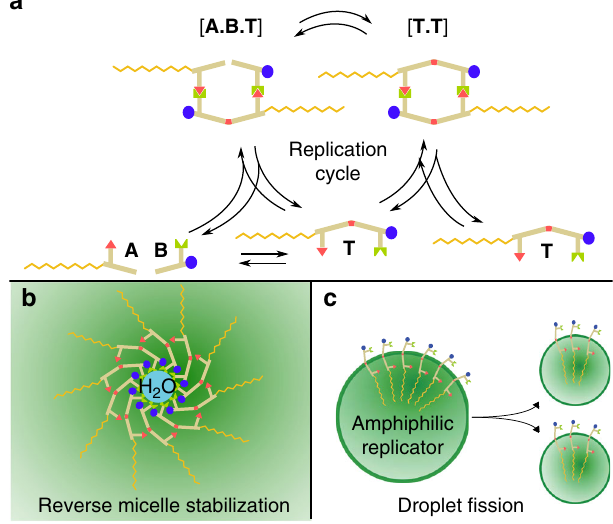
Fig. 1 Formation of an amphiphile from a template self-replication reaction 20 . a Reactants A and B contain complementary recognition sites and react together via a bimolecular reaction to form template T . T